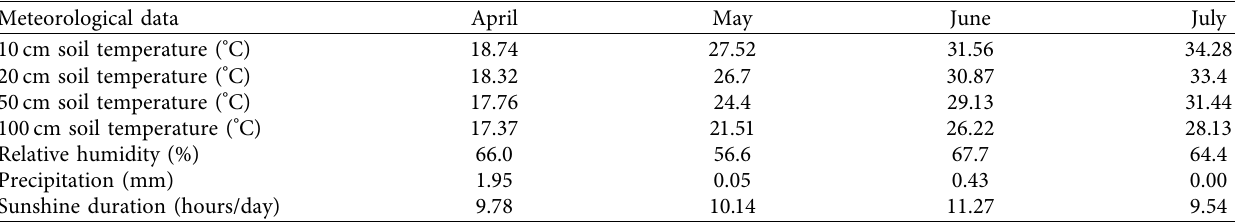
Figure 1: The minimum, maximum, and average air temperature values recorded in the trial area during the control and high-temperature stress trials ( ° C) in the year Table 1: Monthly average meteorological data recorded in the trials area during 2016.